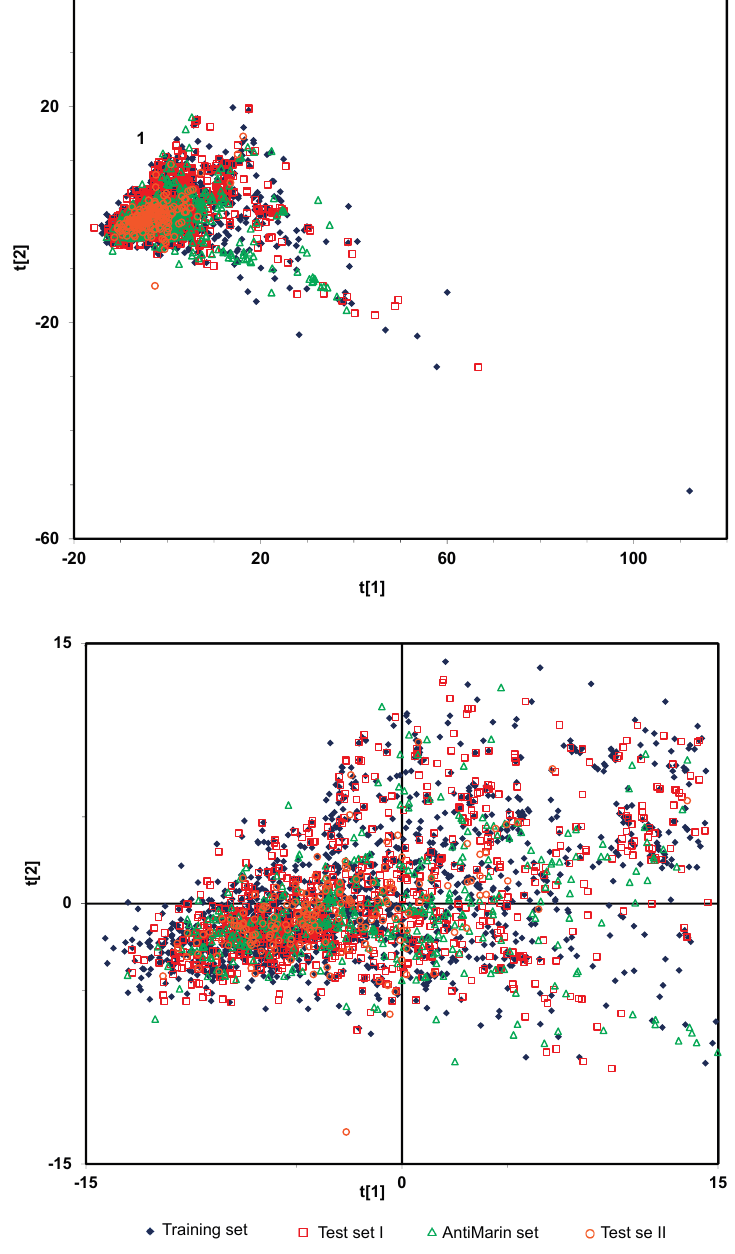
Figure 1. PCA score plot derived from CDK and PM6 descriptors, PC1 (t[1]) versus PC2 (t[2]). The bottom plot is the amplification of the cluster highlighted as